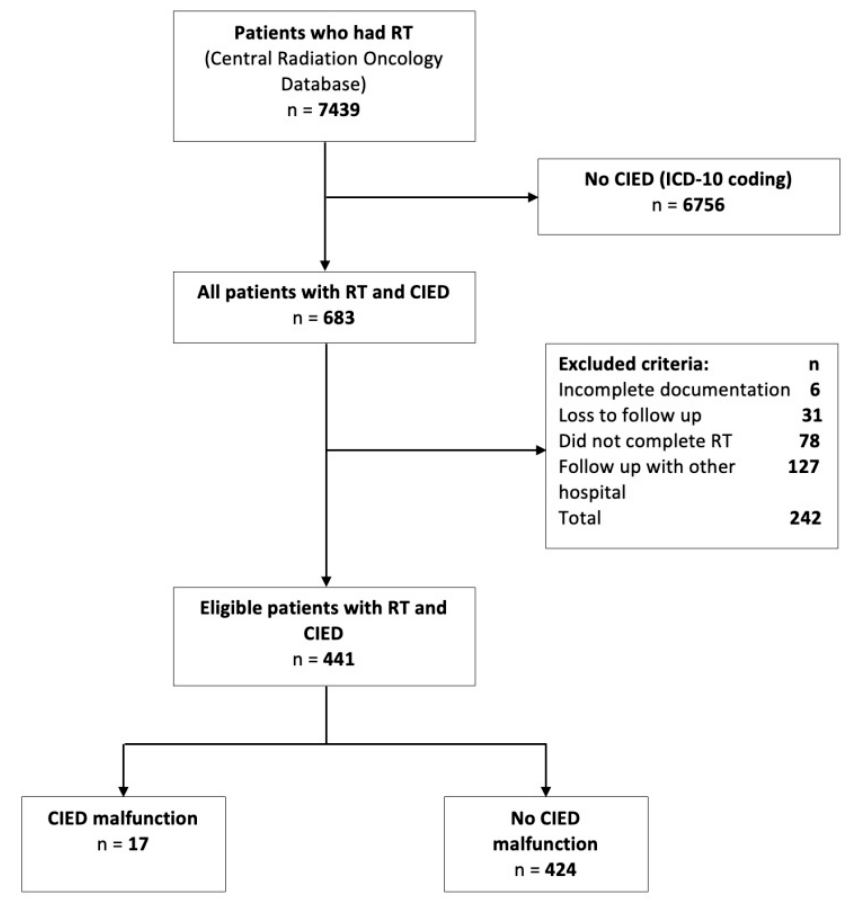
Figure 2. Study flow diagram showing patient selection, exclusions, and distribution of patients. CIED, cardiac implantable electronic device; ICD-10, The International Classification Diagnosis of Disease 10th Version; RT, radiotherapy. Central illustration: Incidence and predictors of cardiac implantable electronic device malfunction (CIED) with radiotherapy (RT). There were 17 patients with CIED malfunction out of 441 patients who underwent RT. Patients with CIED malfunction had a higher median RT cumulative dose (42.5 Gy vs. 36 Gy) and beam energy dose (14 vs. 6.75 MV). Types of CIED malfunction ranges from minor electrical reset, noise oversense with no symptoms, change in lead parameters and unexpected decline in battery life. Adjusted logistic regression analysis identified that CIED from ICD device class, anatomical RT field above the diaphragm and usage of photon beam energy ≥ 10 MV were predictors of CIED malfunction with RT. There was no significant correlation between cumulative RT dose and CIED malfunction. A and P, abdomen and pelvis; CIED, cardiac implantable electronic device; H and N, head and neck; PPM, permanent pacemaker; Gy, Gray; ICD, implantable cardioverter defibrillator; IQR, interquartile range; LL, lower limb; MV, megavolt; RT, radiotherapy; UL, upper limb.